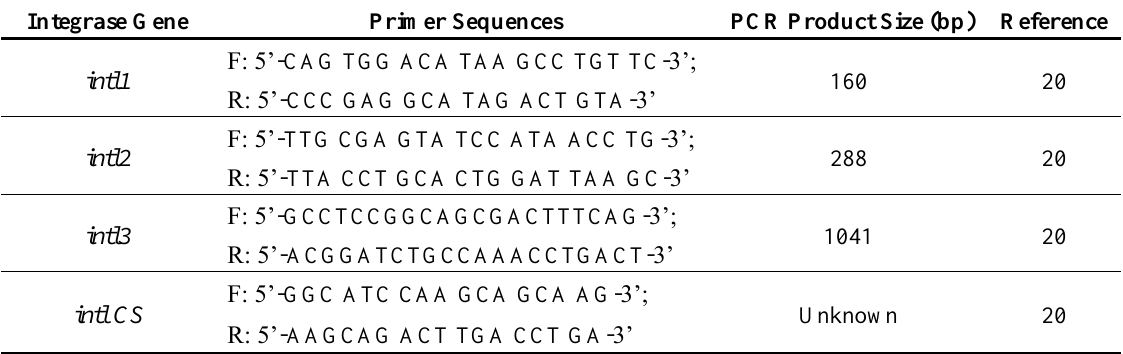
Table 2. Primer sequences and PCR product size of integrase